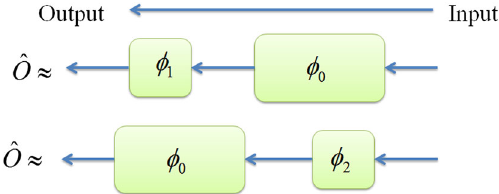
Fig. 4 Schematic diagram for two different generators in quantum cir- cuits. To obtain the some target operator ˆ O from the quantum circuit φ 0 , we have two different ways to add new